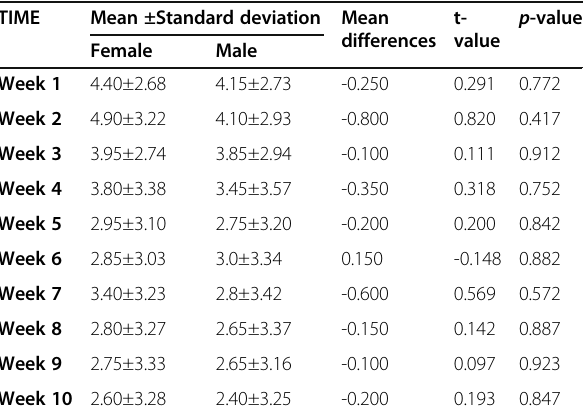
Table 5 The mean comparison of pain levels (post visual analogue scale scores) between males and females across 10 weeks (after the intervention) Mean ±Standard deviation Mean